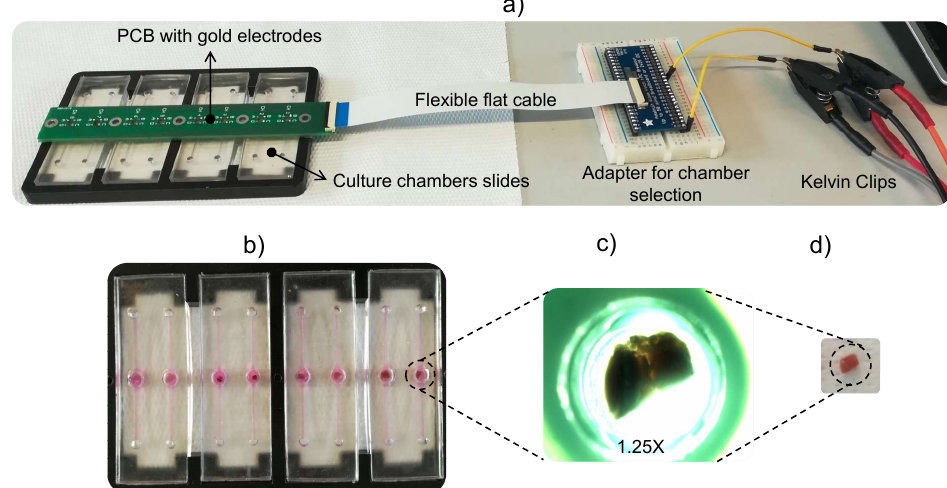
Figure 1. Experimental setup: ( a ) Four culture chamber slides with two chambers each were fabricated in a biocompatible polymer. A PCB held the couple of vertical gold electrodes for each chamber. A flexible flat cable connected the PCB to an external adapter that allowed for manual selection of the culture chamber in which the measurement was performed. Kelvin Clips were connected to the 4192A LF Impedance Analyzer (Keysight Technologies). ( b ) Top view of the culture chambers slides with biopsies. ( c ) Microscopy image of a biopsy suspended in culture medium inside the culture chamber (1.25 × ). ( d ) Non-suspended biopsy outside the culture chamber (geometry obtained with catheter